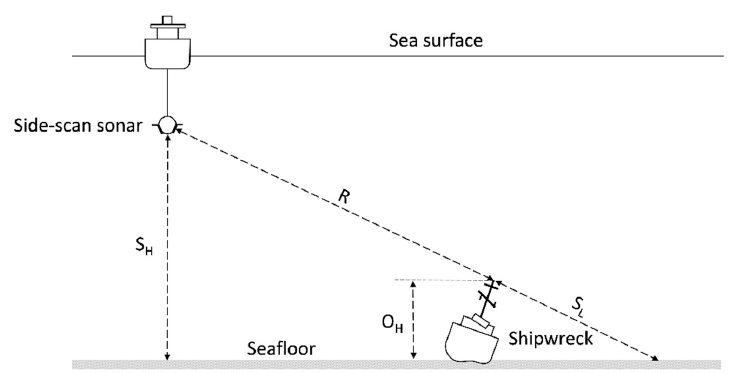
Figure 9. Identification of the wreck’s construction features.